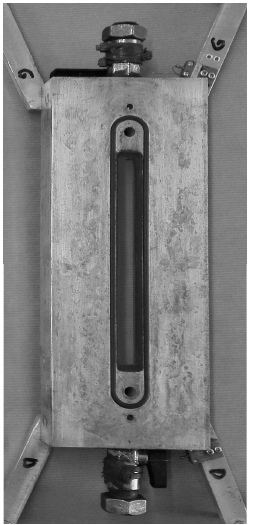
Fig. 3. A view of the test section with a minichannel.